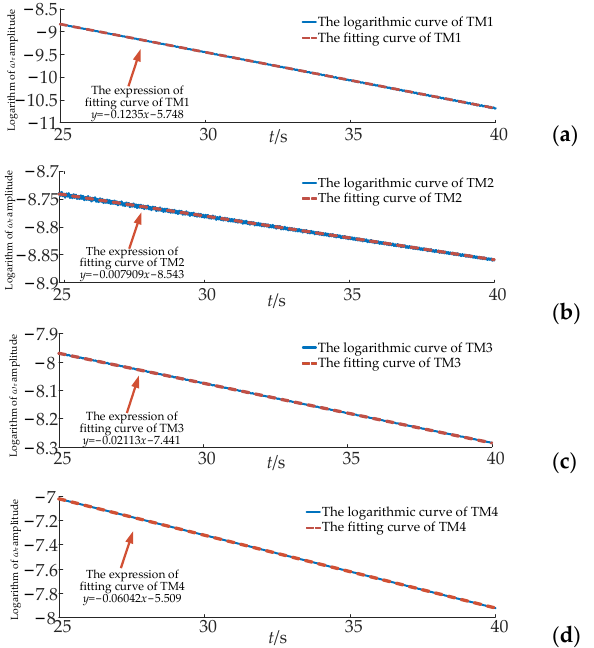
The logarithmic curve of TM4 The fitting curve of TM4 The expression of fitting curve of TM4 y = 0.06042 x 5.509 Figure 8. The comparison diagram of the change curves of the amplitude of ω r after taking the logarithm and fitting curves: ( a ) TM1; ( b ) TM2; ( c ) TM3; ( d ) TM4 .